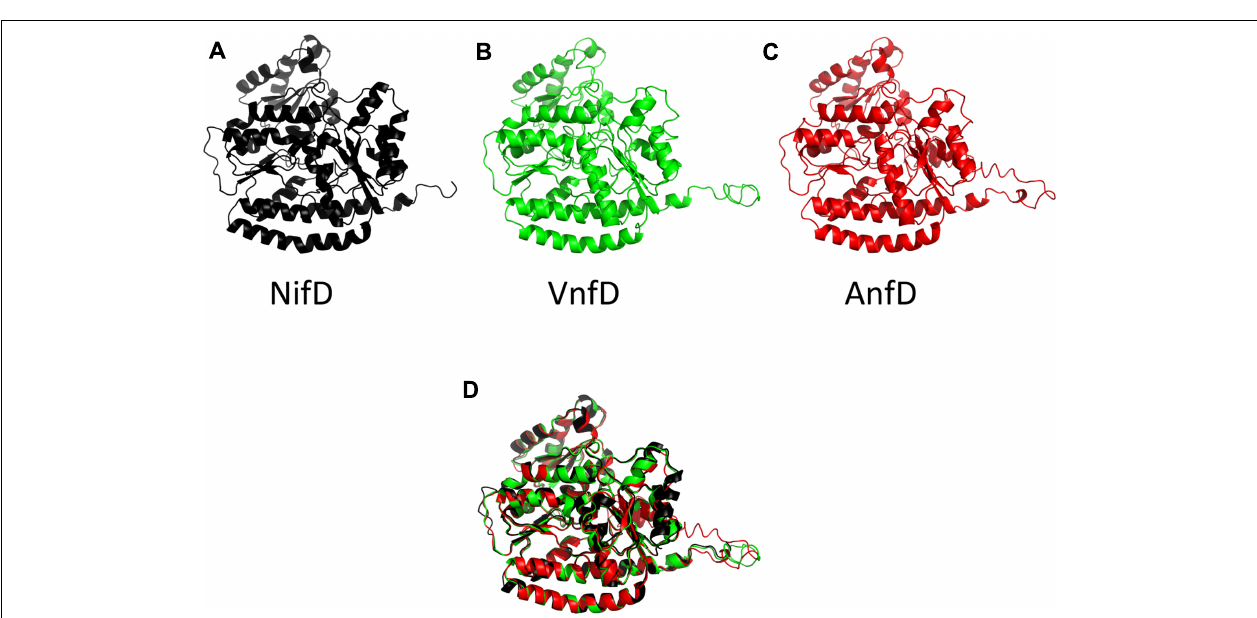
FIGURE 3 | Cartoon diagram of the A. vinelandii nitrogenase D subunits. The NifD structure, drawn from 1M1N is in black (A) , and predicted structures for the A. vinelandii vanadium (VnfD) and Fe-only (AnfD) homologs are in green (B) and red (C) , respectively. A structural superposition of the three as performed in PyMol is shown in (D)